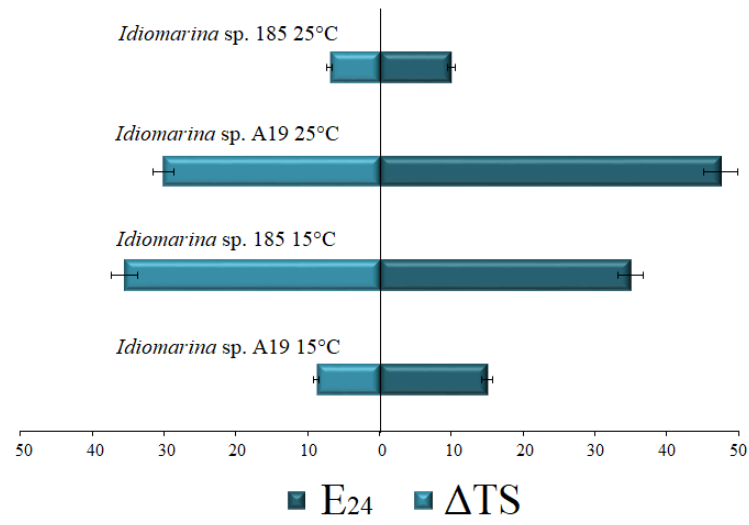
Figure 2. Production of stable emulsion (left side) and surface tension reduction (reported as differ- ence between initial and final value) by Idiomarina sp. A19 and Idiomarina sp. 185 during incubation in BHbp.